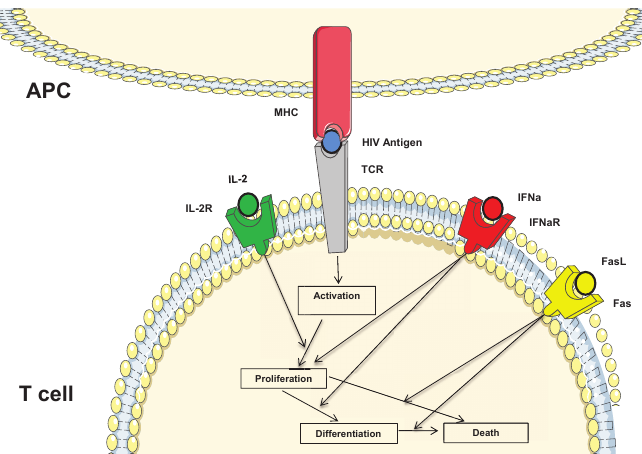
Figure 3. Scheme of the cell fate regulation via TCR, IL-2, IFNa and Fas receptor-mediated signaling in naive T cells to adaptively program the balance of growth-differentiation and